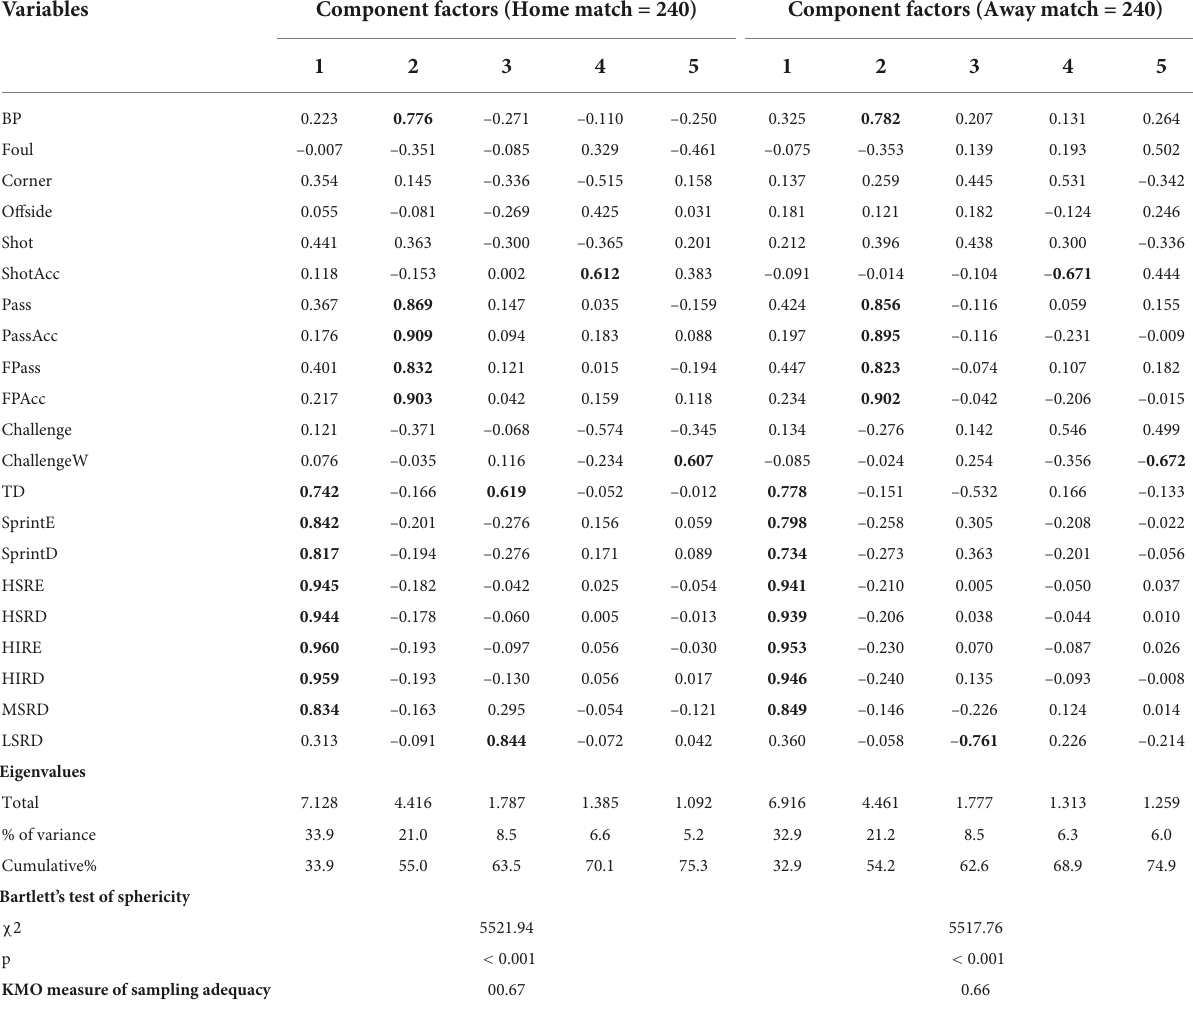
TABLE 2 Component factor loadings, component statistics, Bartlett’s test of sphericity and Kaiser-Meyer-Olkin measure of sampling adequacy of the factor analysis (principal component methods) between home and away